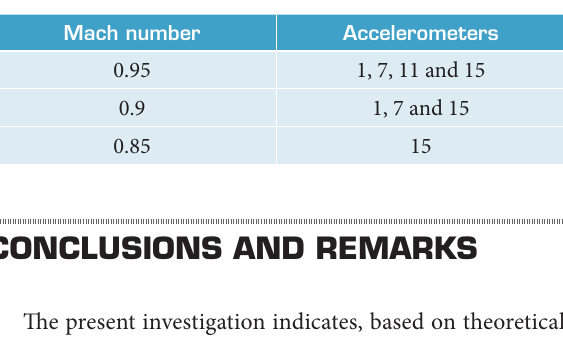
table 4. Saturated Accelerometers versus Mach